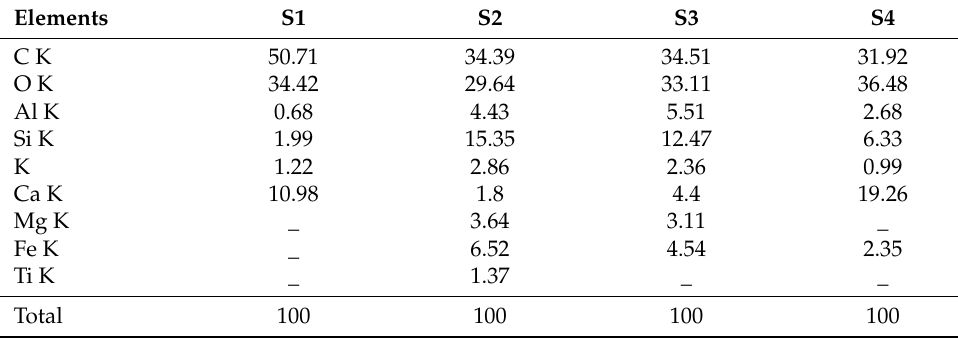
Figure 14. ( a – d ) SEM micrographs of NGP-reinforced composites containing 5% NGPs. Reproduced with permission from Ref. [5]. Copyright (2021), Elsevier Ltd. Table 8. Elemental entities obtained from SEM–EDX spectroscopy (S;